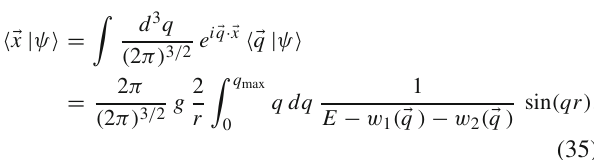
Table 20 Coupling constants to various channels and g i G II with q